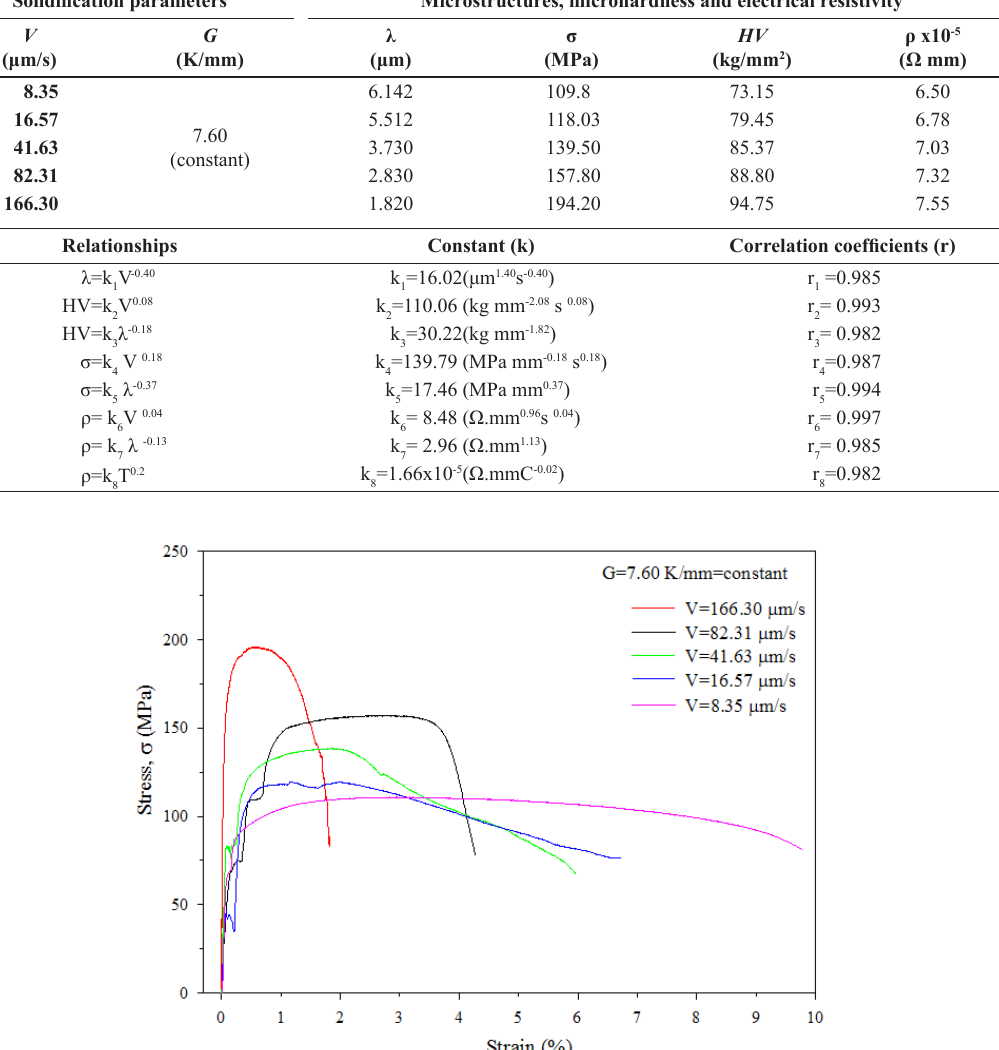
Table 1. Solidification processing parameters, microstructures, microhardness, tensile stress and electrical resistivity for directional solidified Al-12.6wt%Si-2wt%Co alloy and the relationships between them. Solidification parameters